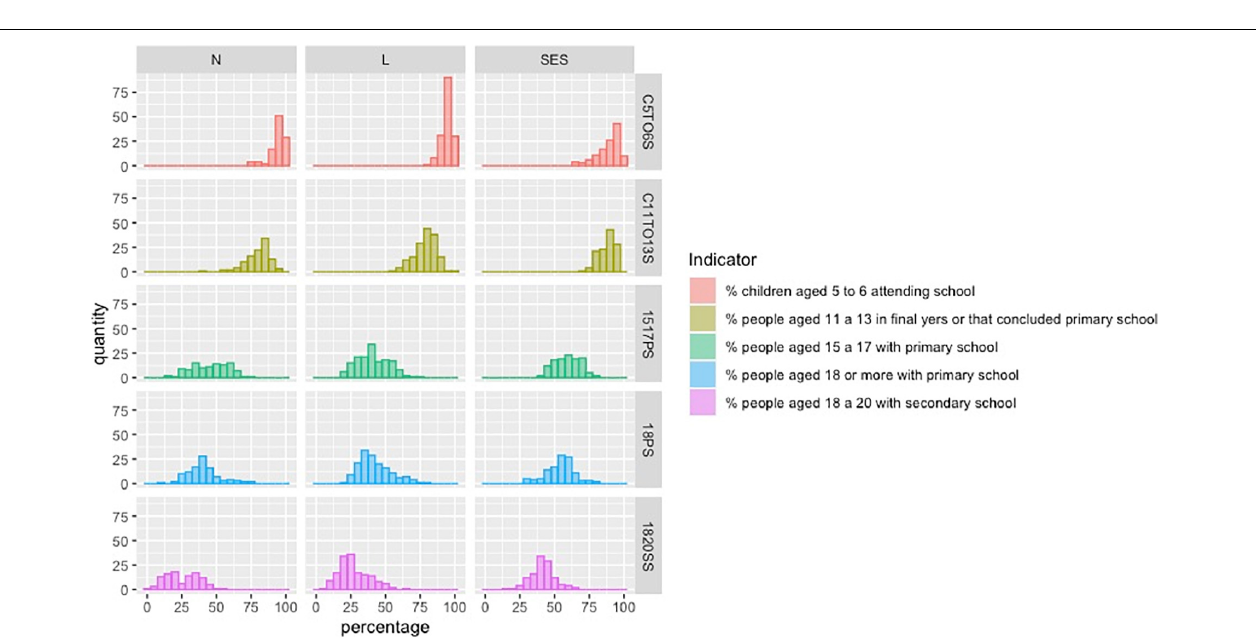
FIGURE 7 | Histogram of the municipal distribution based on the HDMI indicators of the Educational Dimension. Elaborated by the authors with data from PNUD et al. (2020).